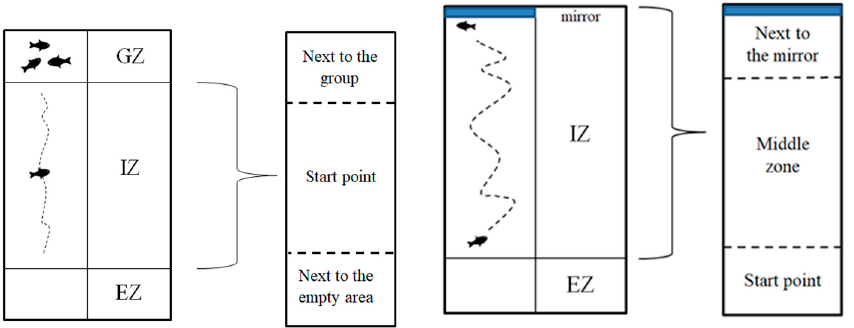
Figure 2. Architecture of the mazes and the main areas of it for social interaction test ( left ) and aggression test ( right ) where GZ = group zone, IZ = individual zone and EZ = empty zone.